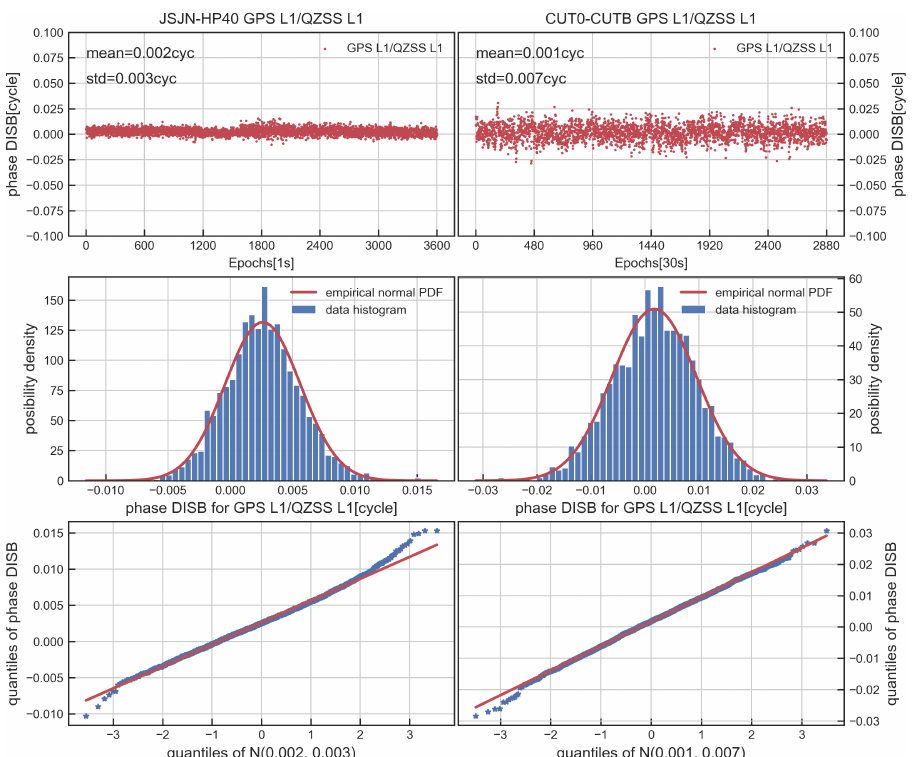
Figure 7. Time series, distribution and QQ plot of GPS L1/QZSS L1 phase DISB for JSJN − HP40 ( left ) and CUT0 − CUTB ( right